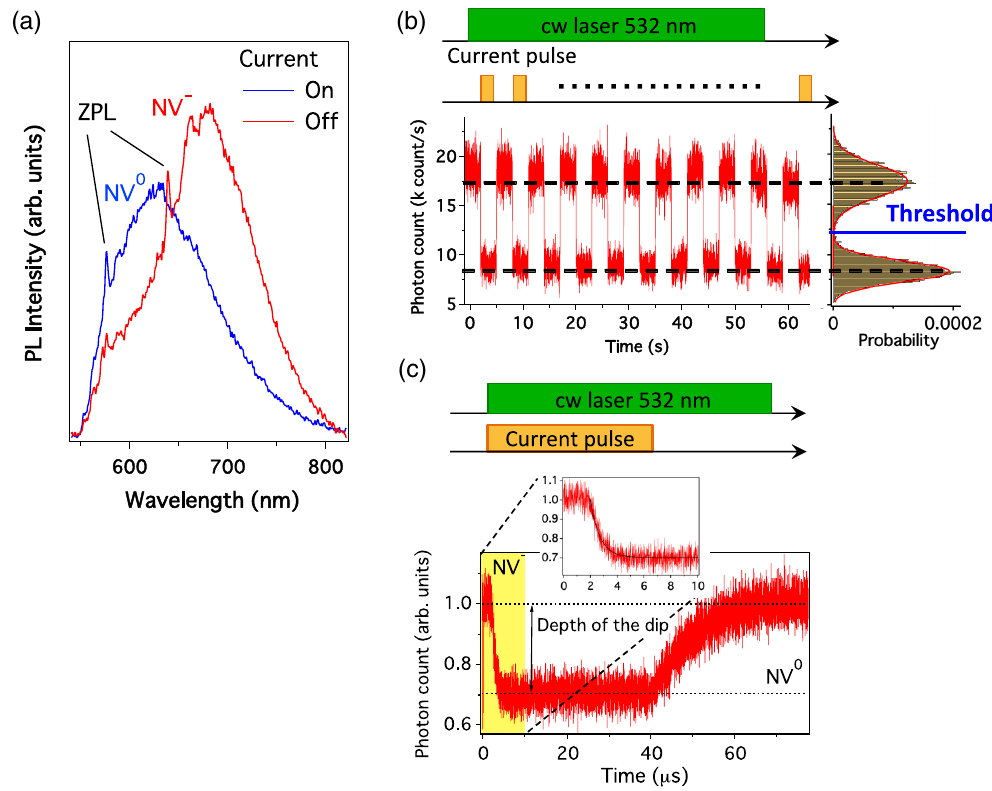
FIG. 2. (a) PL comparison of the different dynamical steady states and charge states. NV 0 states were induced by current injection of 70 μ A. The excitation laser power was 0.3 mW. (b) Real-time trace of the fluorescence intensity with current switching between 0 and 0.2 mA. On the upper side, the 532-nm irradiation laser light and timing of the injected current pulse are shown. The fluorescence intensity histogram is shown on the right. The solid red line was obtained from fitting of the two Gaussian distributions. The blue straight line indicates the threshold of the two dynamical steady states and charge states. (c) Charge-state transitions between NV − and NV 0 in the fast time-resolution measurement, which was averaged after 4 × 10 6 repetitions. On the upper side, the 532-nm irradiation laser light (0.2 mW) and timing of the injected current pulse (0.3 mA) is shown. In the inset, the expanded region for the change from higher to lower photon count is shown. It can be fitted with a single exponential e − λ t , as shown by the black